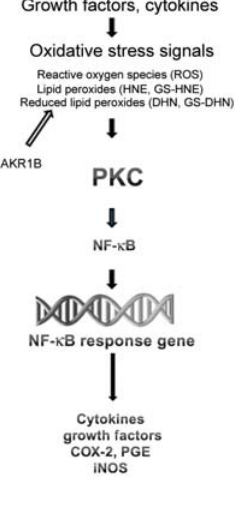
Figure 3 Involvement of AKR1B proteins in oxidative stress